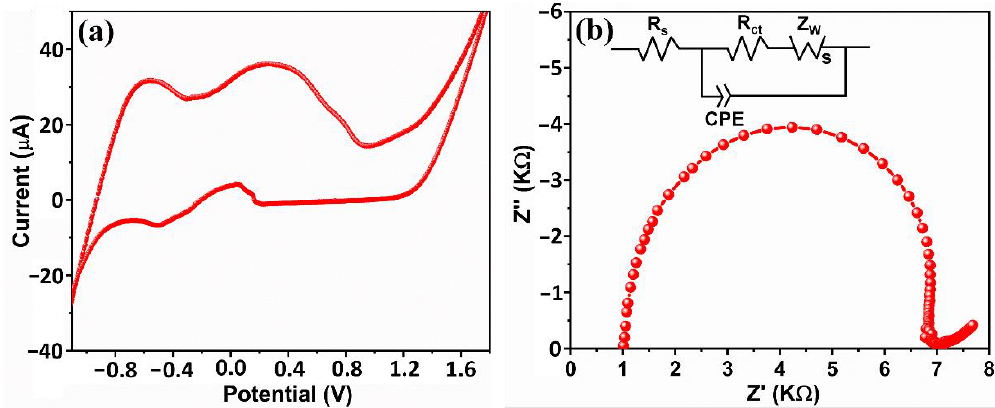
Figure 9. Cyclic voltammetry ( a ), Nyquist plot ( b ) of MgO NBs.